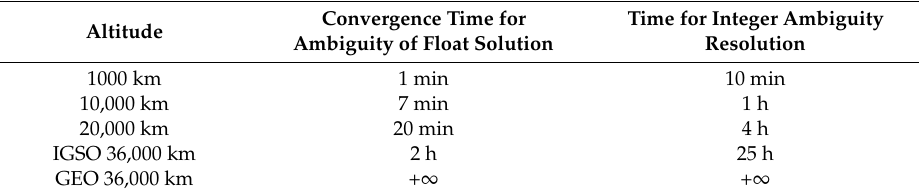
Table 2. Ambiguity Solution Related to the Altitude of